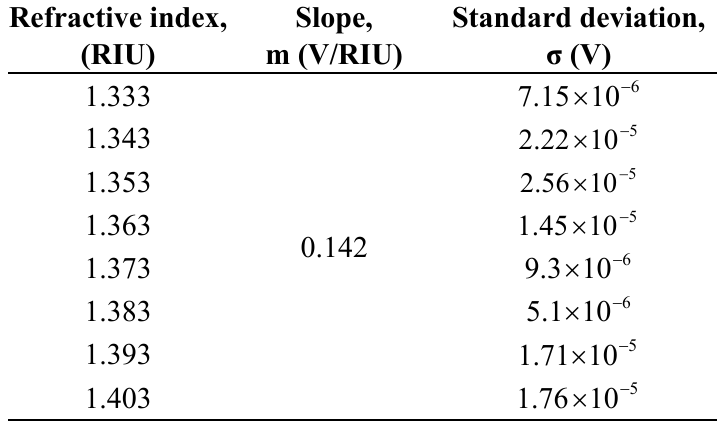
Table 1. Standard deviation of sensor response at different refractive indexes for a sensing fiber with five D-shaped